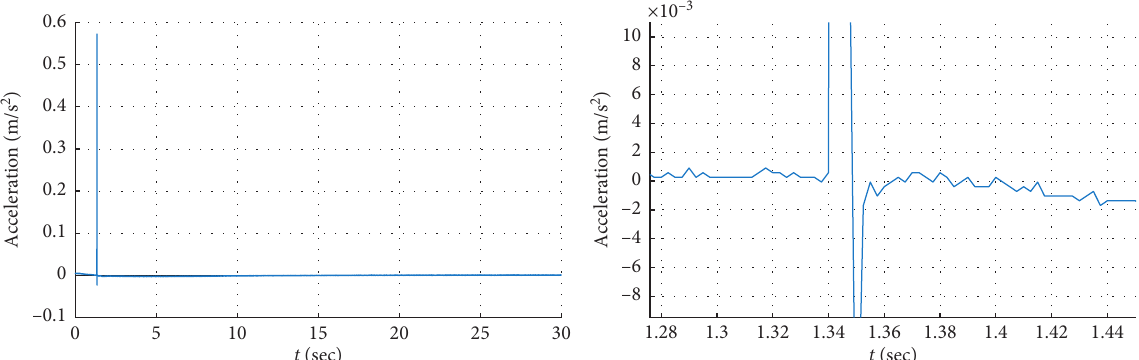
Figure 9: History of the exerted impact load by using the hammer at the free end of the beam (experimental data).